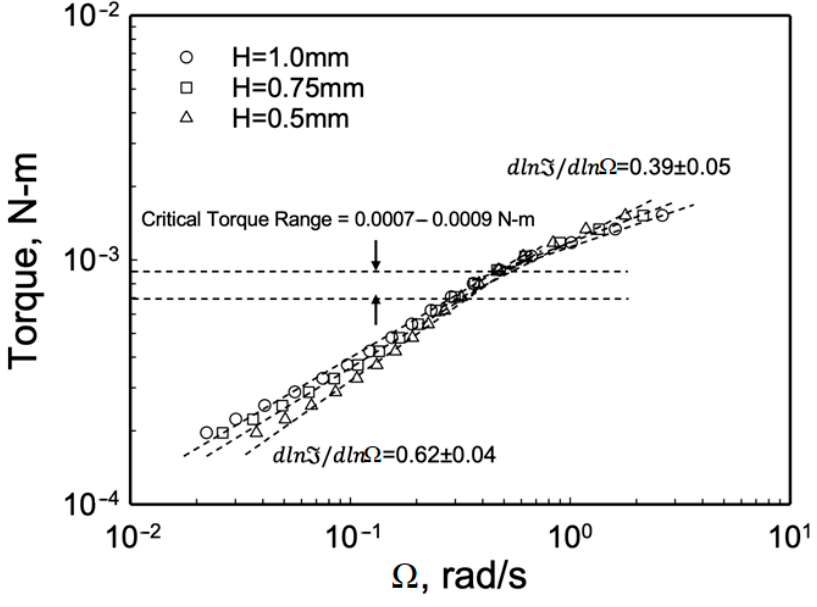
ℑ Figure 7. Steady torque, (cid:61) , versus the rotational speed, Ω , at the edge for three gaps. In general, the wall slip velocity versus the shear stress behavior of complex fluids, including viscoplastic fluids, can be analyzed via systematic changes in the surface to volume ratio of the viscometer, i.e., by changing the gap, H [30,114,115] akin to the method suggested by Mooney for flow-through circular tubes [100]: